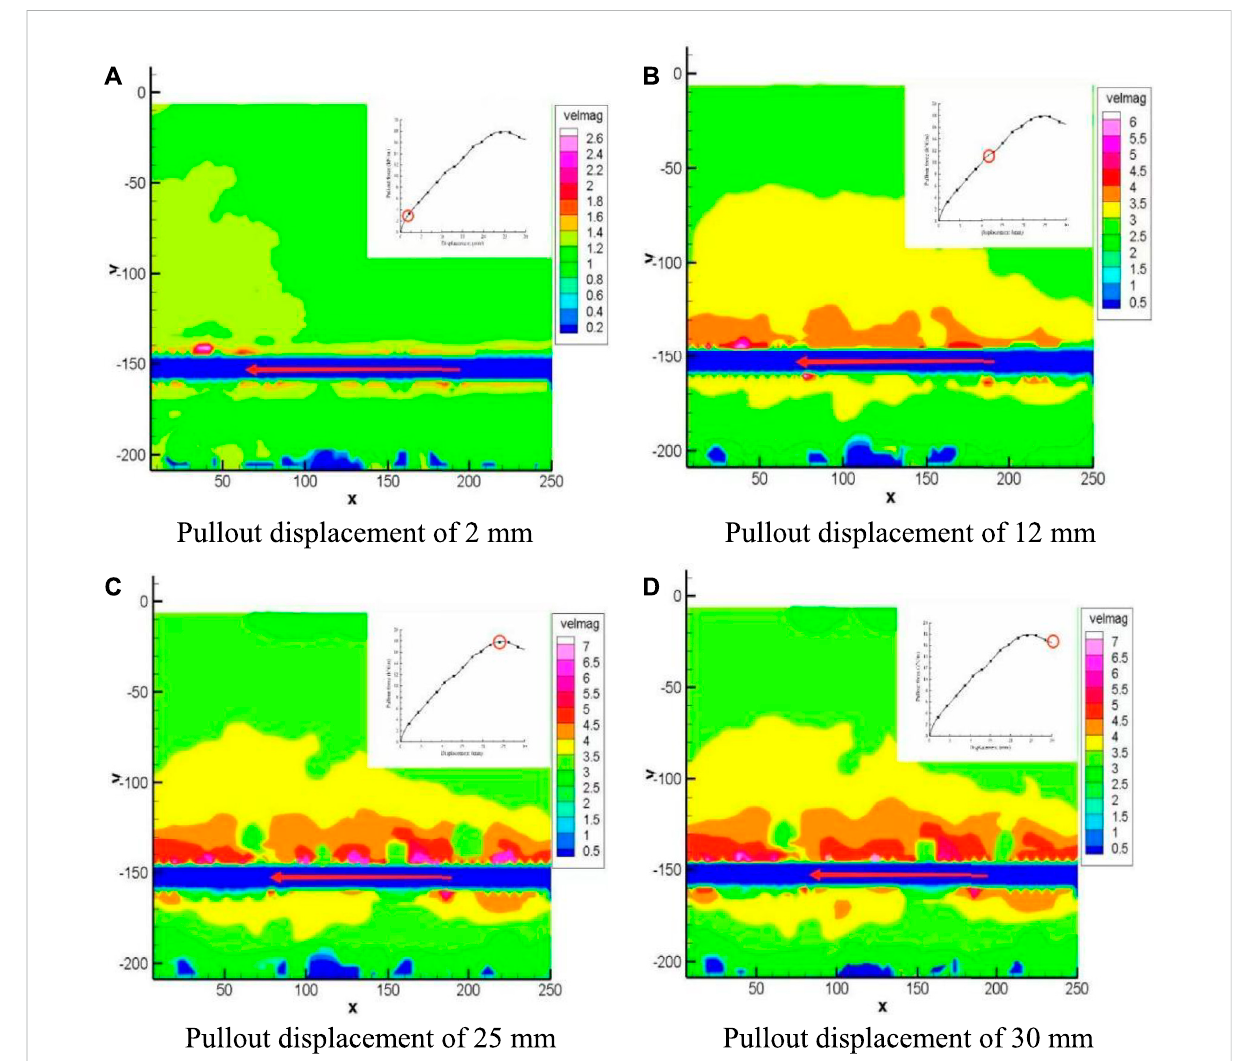
FIGURE 5 The change law of displacementcloud map. (A) Pullout displacement of 2 mm. (B) Pullout displacement of 12 mm. (C) Pullout displacement of 25 mm. (D) Pullout displacement of 30